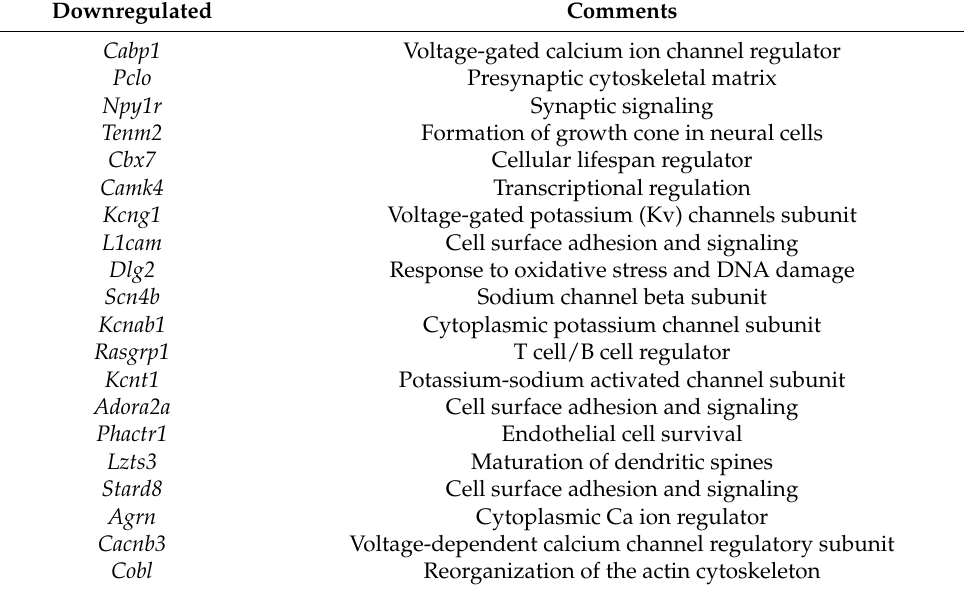
Table 3. Highly repeated down-regulated genes in